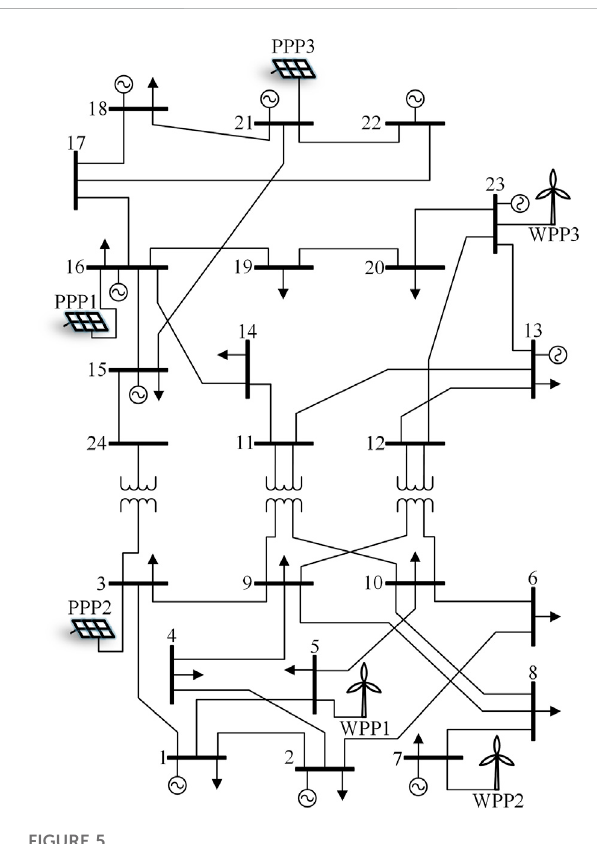
FIGURE 5 Structure of the improved IEEE RTS 24-bus system.